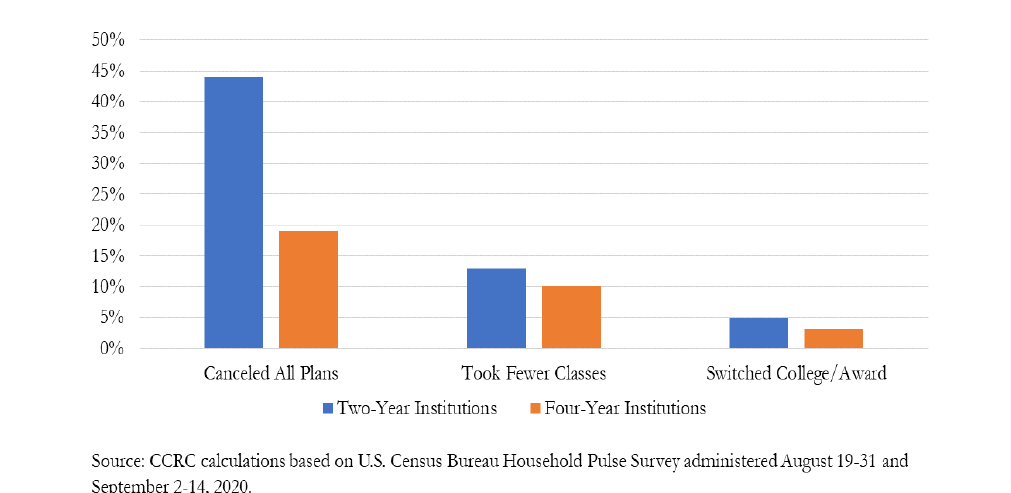
Figure 3: Households Canceling or Changing Plans for College, Fall